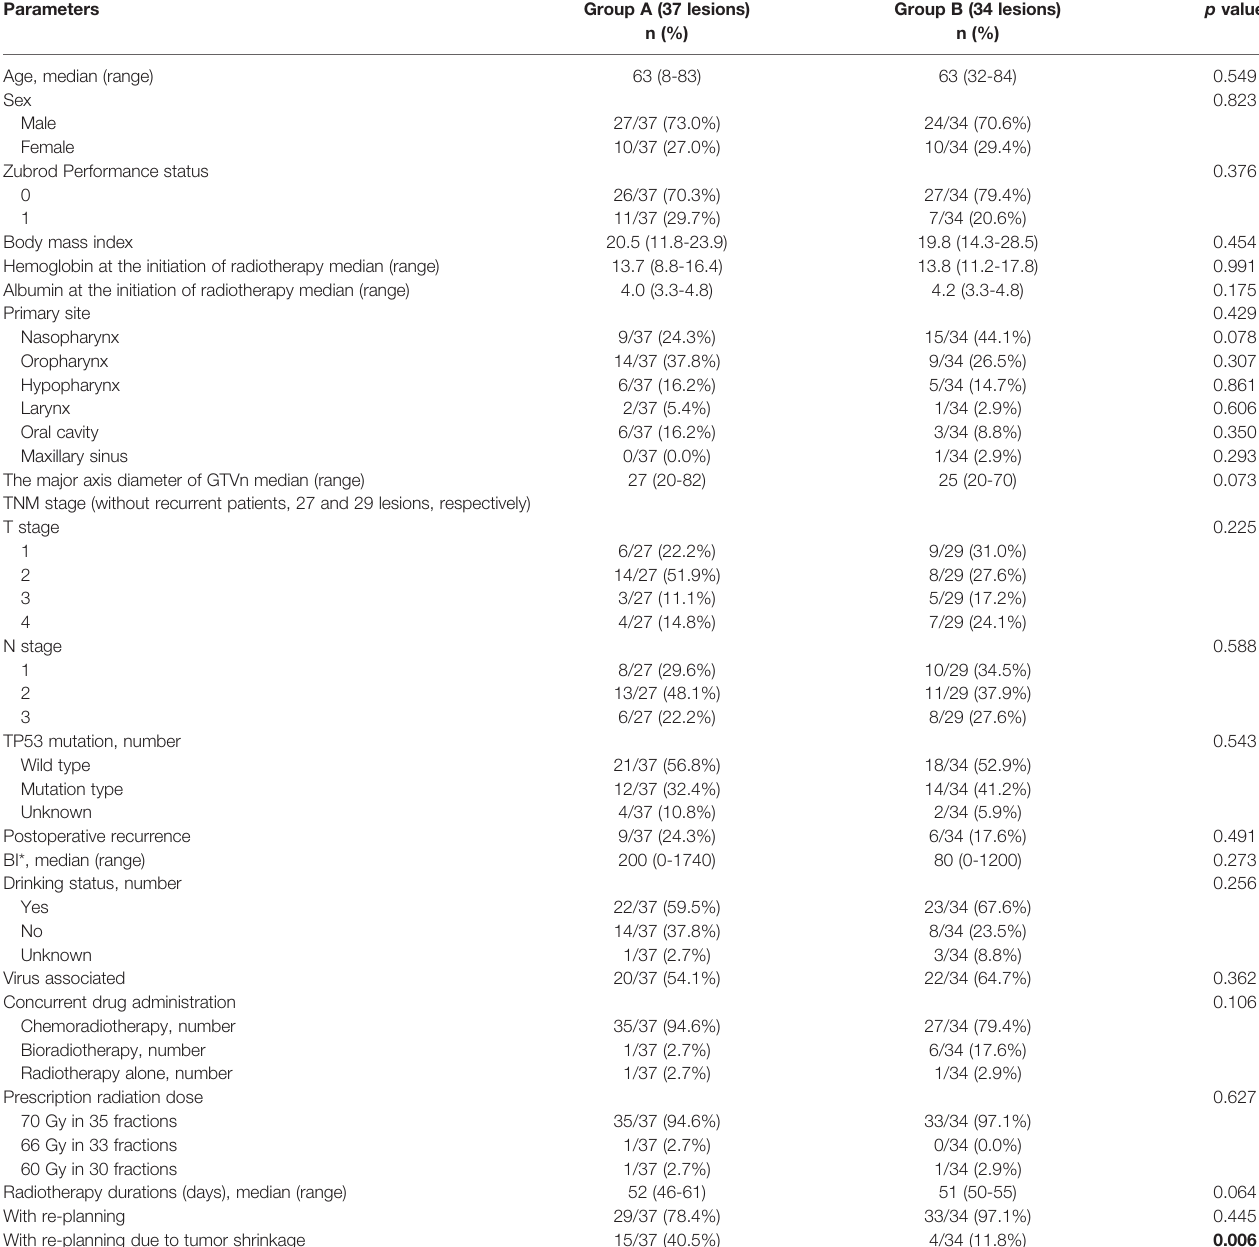
TABLE 2 | Patient and treatment characteristics in group A and B with lesion-based grouping (71 neck lymph nodes).